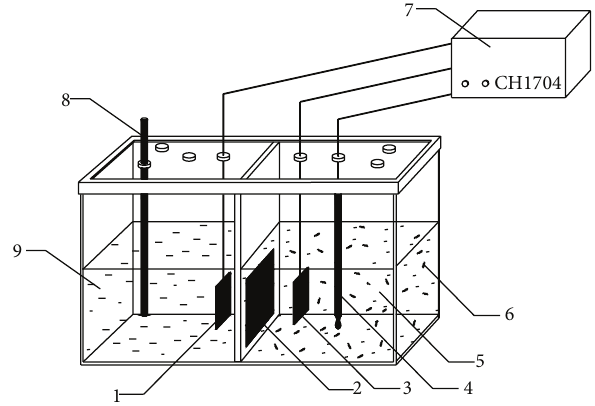
Figure 2: Schematic structure of the spirulina biosolar cell. 1: cathode, 2: proton exchange membrane, 3: anode, 4: reference electrode, 5: anolyte, 6: spirulina, 7: electrochemical workstation, 8: intake tube, and 9: